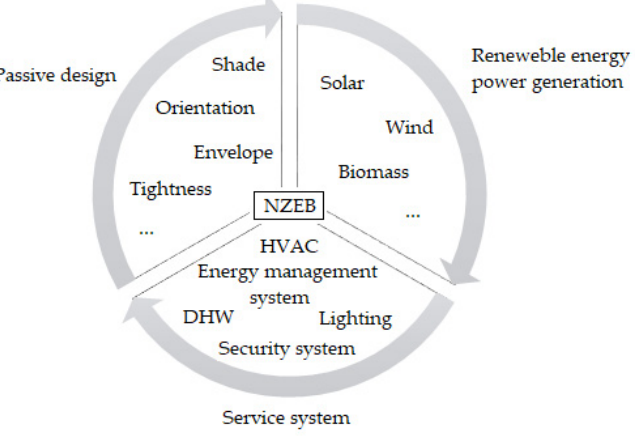
Figure 1. Design elements for NZEB.